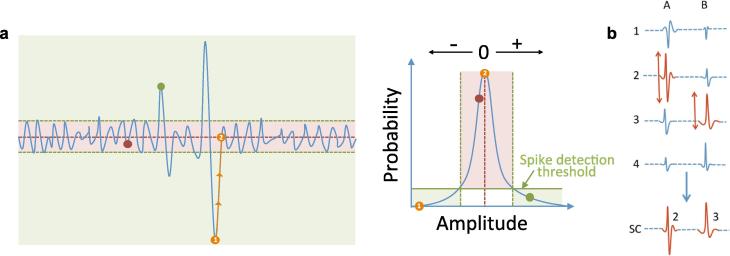
Data processing. (a) Probability threshold. The spike detection threshold was based on the probability of a given amplitude occurring in the thirty-minute recording. A spike’s duration was found by tracking the spike to its nearest zero point (orange circles). Adjacent phases (positive-negative transition) were joined and recorded as a single spike. (b) Principle of the super-channel (SC). For spikes A and B, the channel (1–4) with the highest peak-trough amplitude (shown in red) was transferred into the SC. The channel of origin for each spike was stored. (For interpretation of the references to colour in this figure legend, the reader is referred to the web version of this article.).